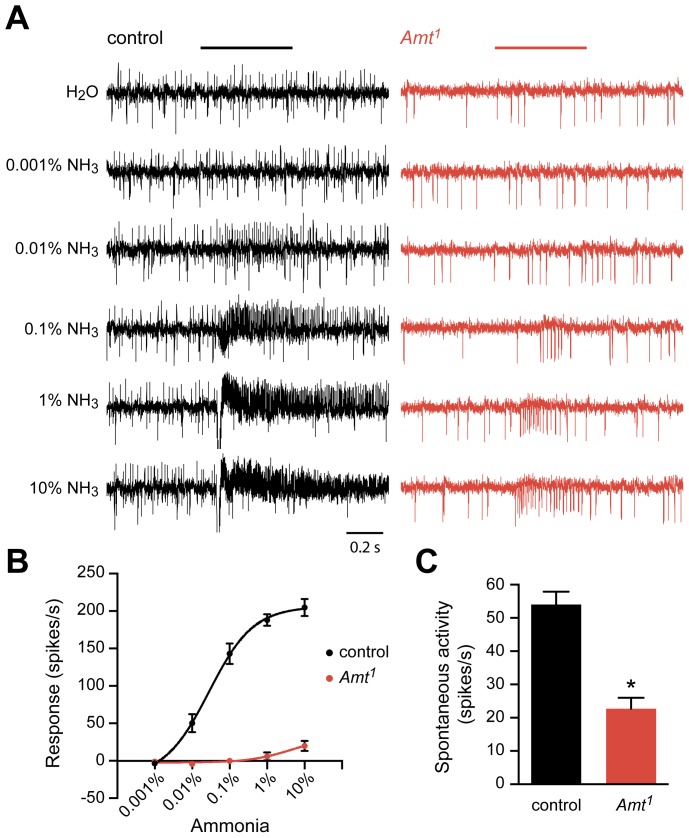
Reduced response of ac1 sensilla to ammonia in Amt.
(A) Extracellular recordings of neuronal responses to a 500 ms pulse of either water or ammonia from ac1 sensilla of control and Amt1. ac1 sensilla were identified by their location and response characteristics (see Materials and Methods). Ammonia responses were quantified by subtracting the spike frequency elicited by water (solvent) from that elicited by ammonia and are plotted in (B). (C) The spontaneous spiking activity in ac1 sensilla was significantly lower in Amt1 mutant sensilla compared to controls (n = 9 each, p<0.0001).